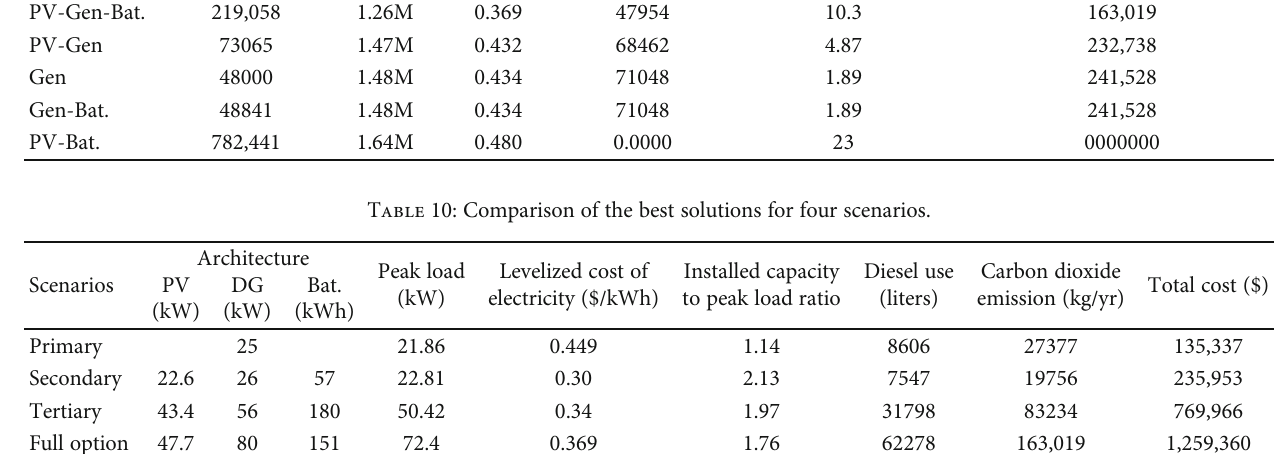
Table 9: Di ff erent architectures of energy sources and their performance for the full-option scenario. Architecture